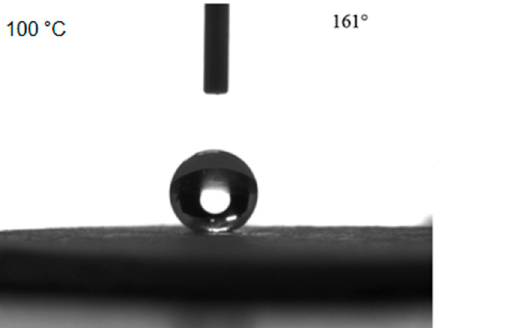
Figure 6. Contact angle measurement results for the bulk surface after 100 ° C heat treatment.